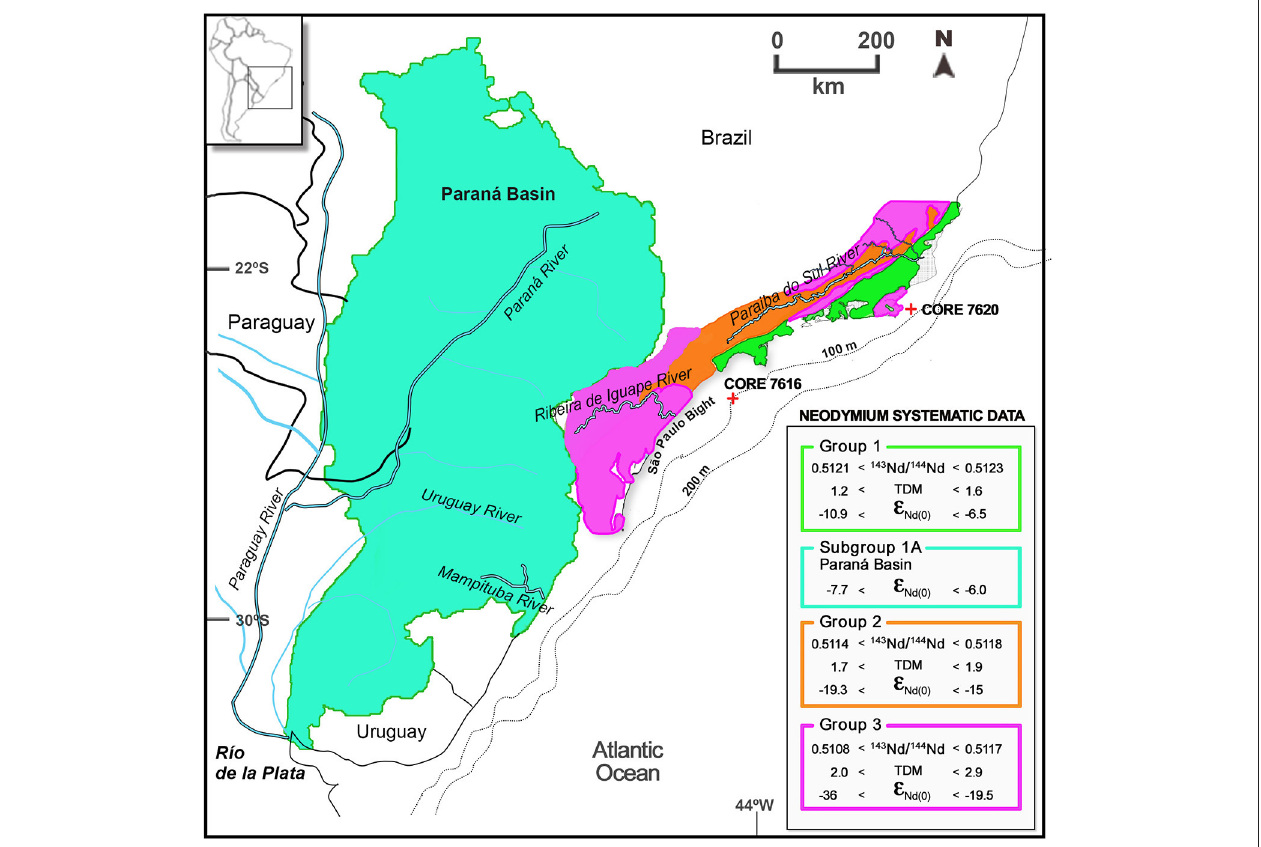
FIGURE 6 | Neodymium isotope distribution map of the investigated source rocks based on PCA and Cluster analyses results. Group 1: represented by the green (Coastal domains from the Ribeira belt and bluish green subgroup 1A (sedimentary rocks of the Paraná basin); Group 2: represented by the orange (Paraíba do Sul and Embú domains from the Ribeira belt); Group 3: represented by the pink (Rocks from older pre-Cambrian domains of the Ribeira belt and the Luís Alves craton).